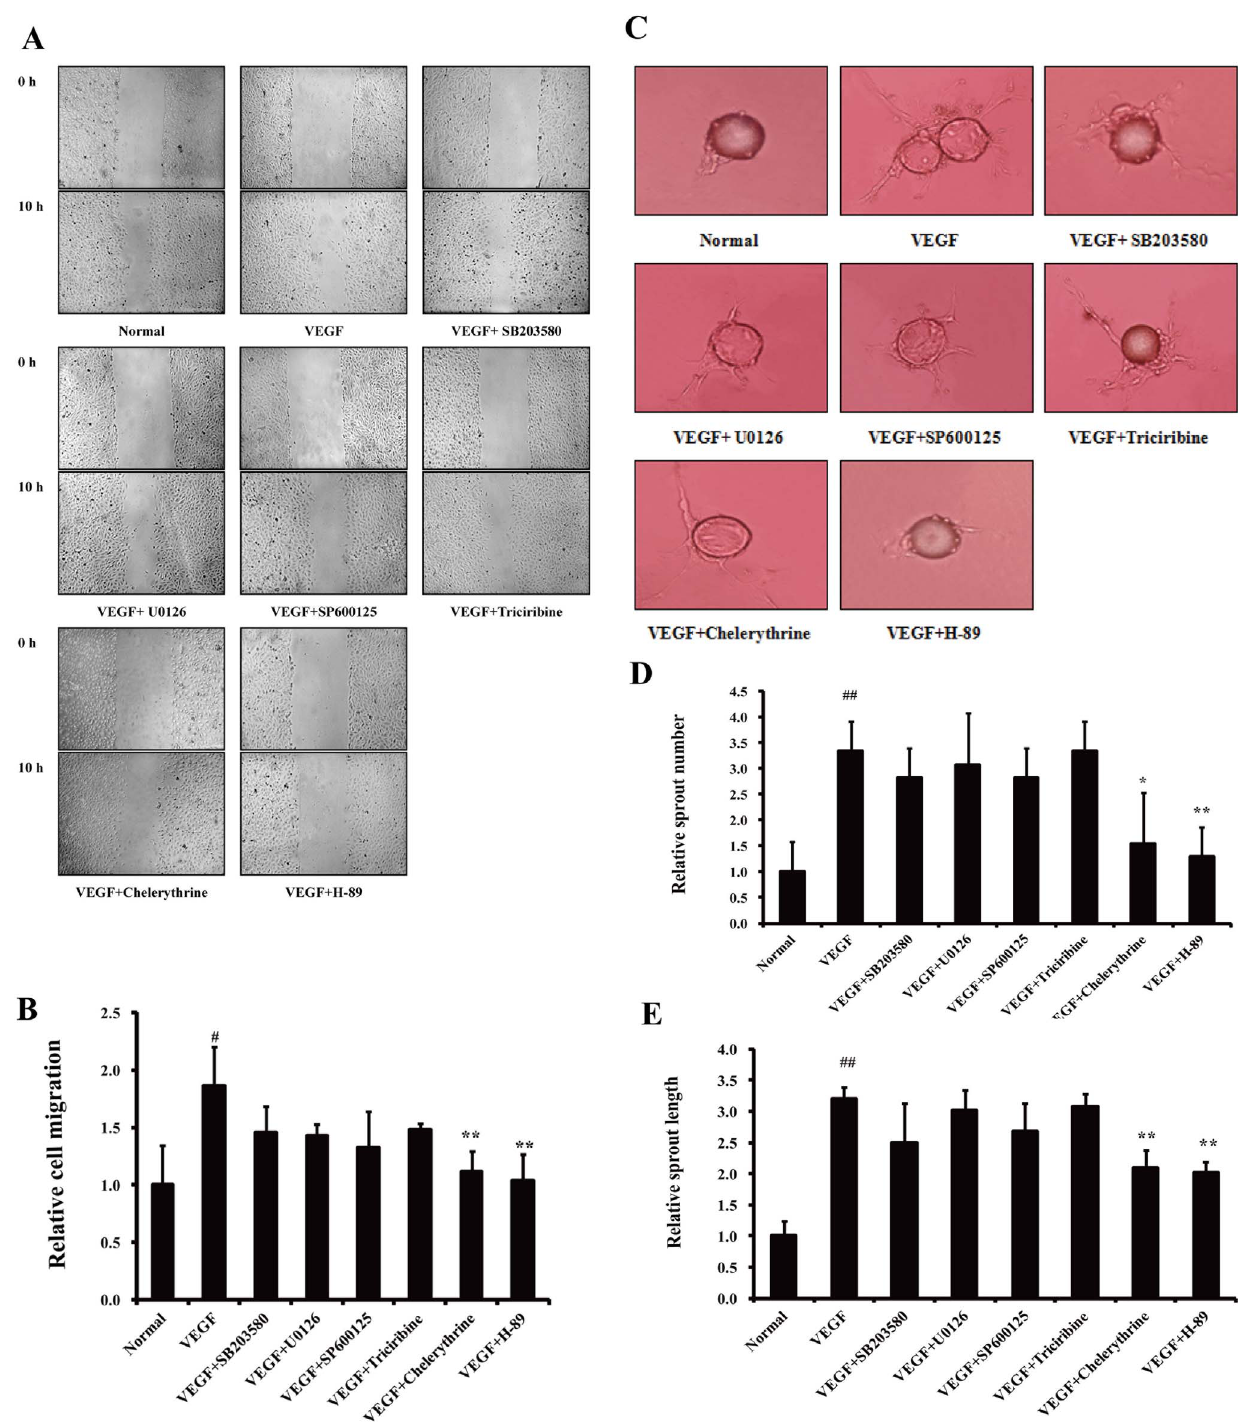
Figure 3. The role of the PKA pathway in the VEGF-induced endothelial cell migration. ( A ). Effects of specific inhibitors of various pathways on wound healing. Scratch wounds were created in cell monolayers of HUVECs using a sterile pipette tip. Then cells were cultured with inhibitors (10 m M) in the presence of VEGF (10 ng/ml) for 10 h. ( B ). Quantification of wound area (The initial wound area minus wound area after 10 h). ( C ). Effects of specific inhibitors of various pathways on VEGF-induced sprouting of endothelial-cell-coated beads in fibrin gel. Cells on beads were exposed to different treatments, and photographs were taken on day 14. ( D ). Quantification of sprout number. ( E ). Quantification of sprout length. The data are expressed as mean 6 SD of three independent experiments. # P , 0.05, ## P , 0.01 vs . normal group; * P , 0.05, ** P , 0.01 vs . VEGF group. (original magnification: 6 100 in A, 6 200 in B).